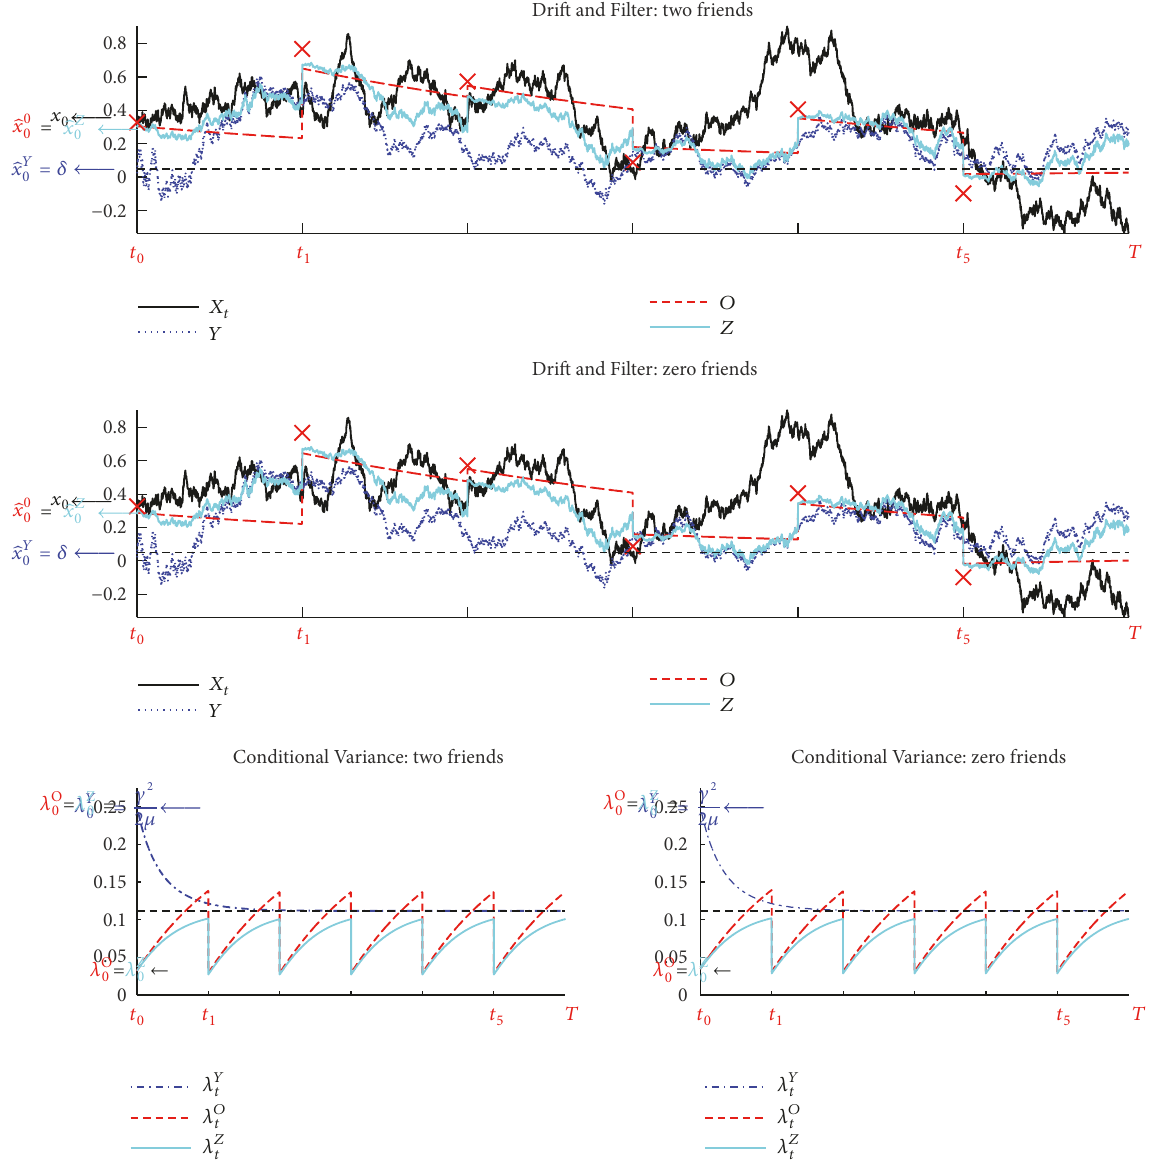
Figure 1: Panel 1: The drift 𝑋 𝑡 and filtered estimates 𝑋 𝐻 𝑡 for the case when the borrower with degree 𝜂 = 2 . Panel 2: The drift 𝑋 𝑡 and filtered estimates 𝑋 𝐻 𝑡 for the case when the borrower with degree 𝜂 = 0 . Panel 3 and 4: The conditional variances 𝜆 H 𝑡 when the degrees 𝜂 𝑡 = 2 and = 0 𝜂 𝑡